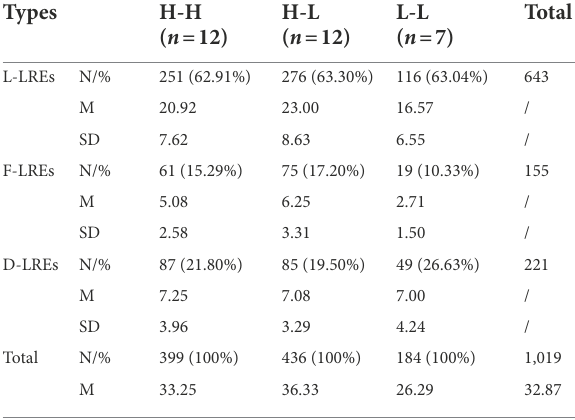
TABLE 2 The frequency and type of LREs by proficiency